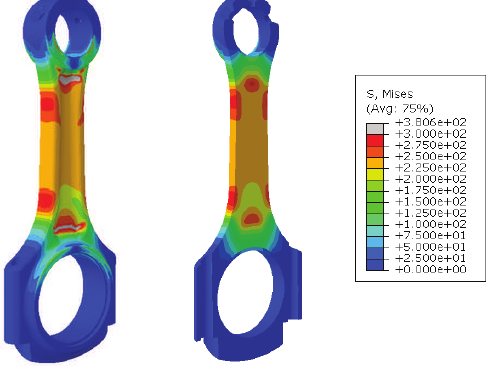
Fig. 16. Results of simulation of connecting rod model 6